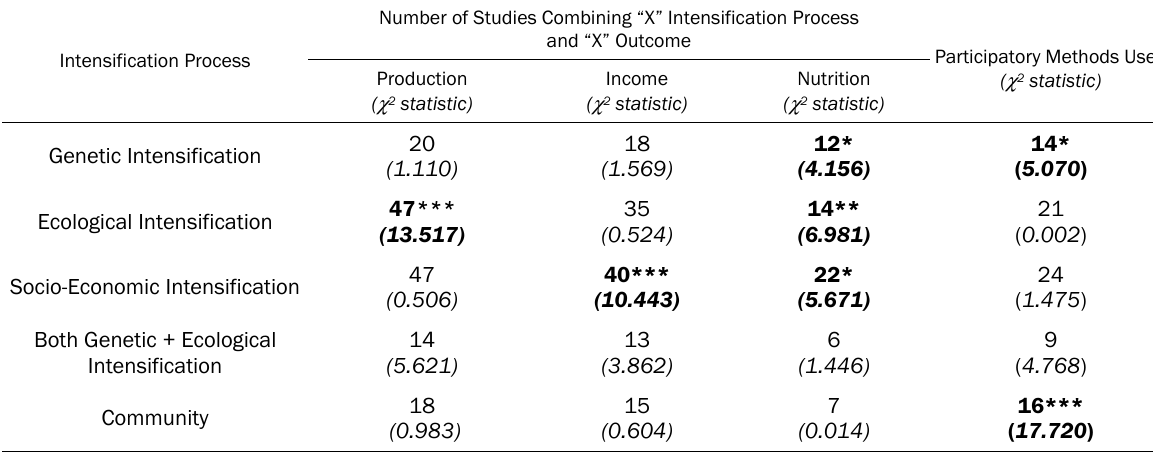
Table 2. Associations Between Major Variables ( N = 58) a